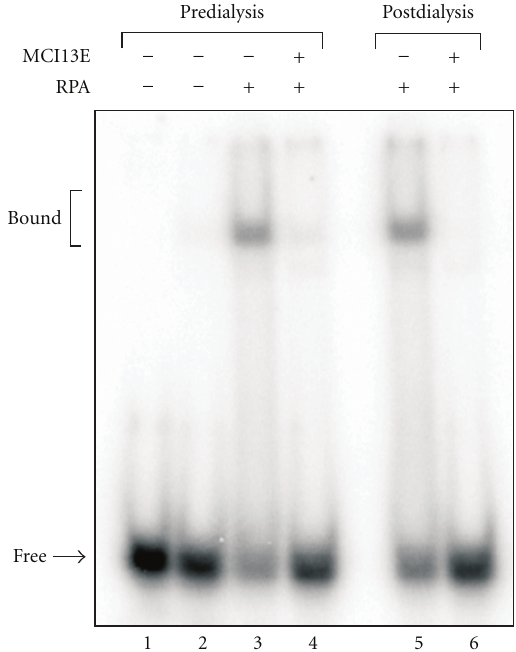
Figure 5: Irreversible inactivation of full-length heterotrimeric RPA by MCI13E. Incubation of RPA with MCI13E, dialysis, and recovery were performed as described in the legend to Figure 3. DNA binding activity of the resulting protein was assessed by EMSA using a 5 (cid:2) -[ 32 P]-ss 34-base DNA as described in “Section 2.” Lanes 1–4 predialysis, lanes 5 and 6